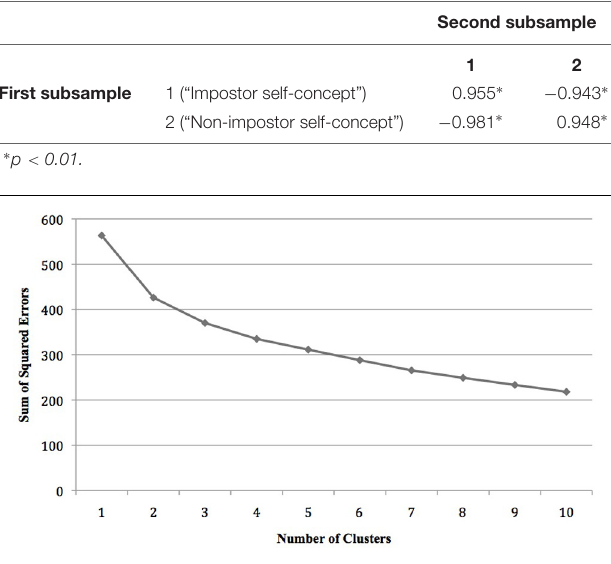
FIGURE 3 | Heterogeneity measures across the final 10 fusion steps ( n = 48).